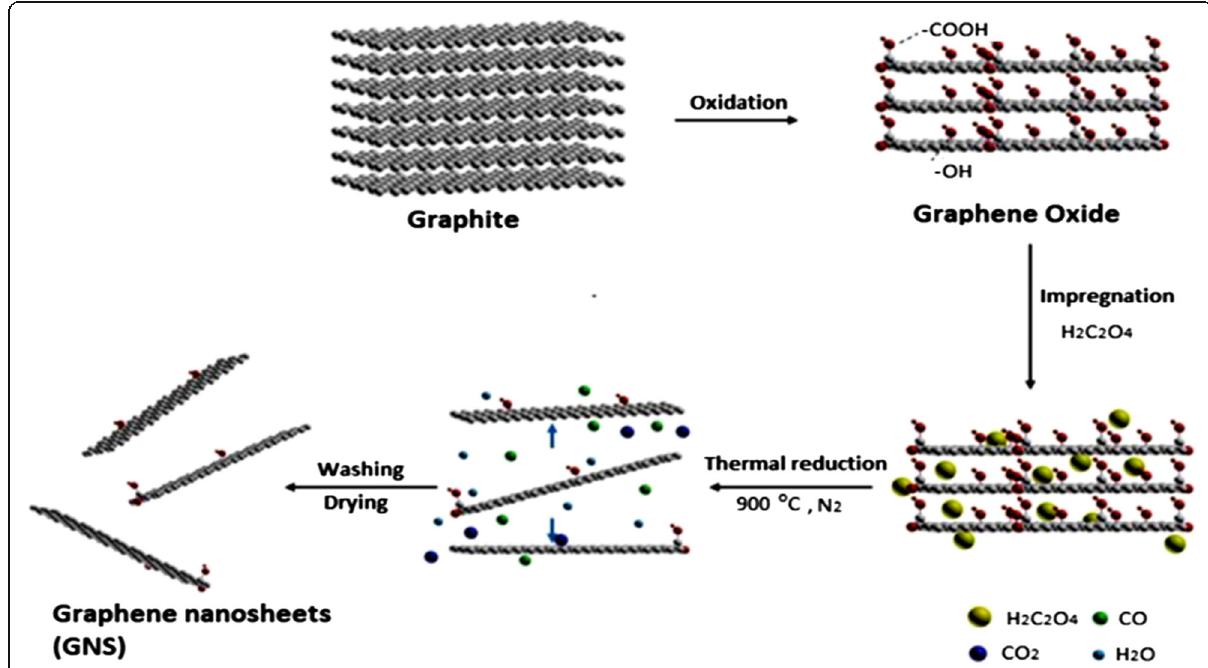
Fig. 4 illustration of the preparation of graphite oxide to graphene nanosheets (GNS) by using oxalic acid